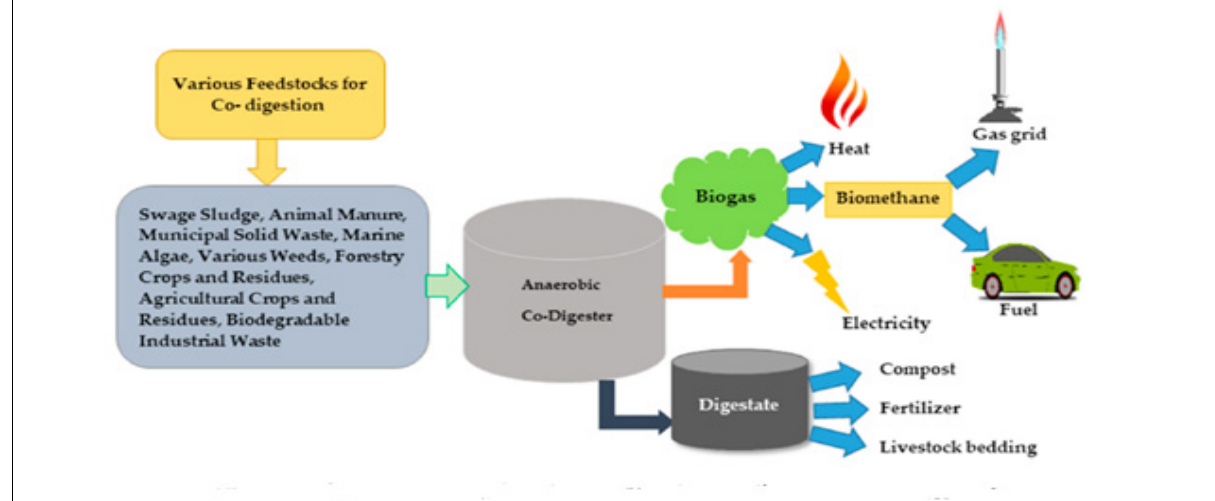
Figure 2: A diagram of multi-feedstock co-digestion in energy